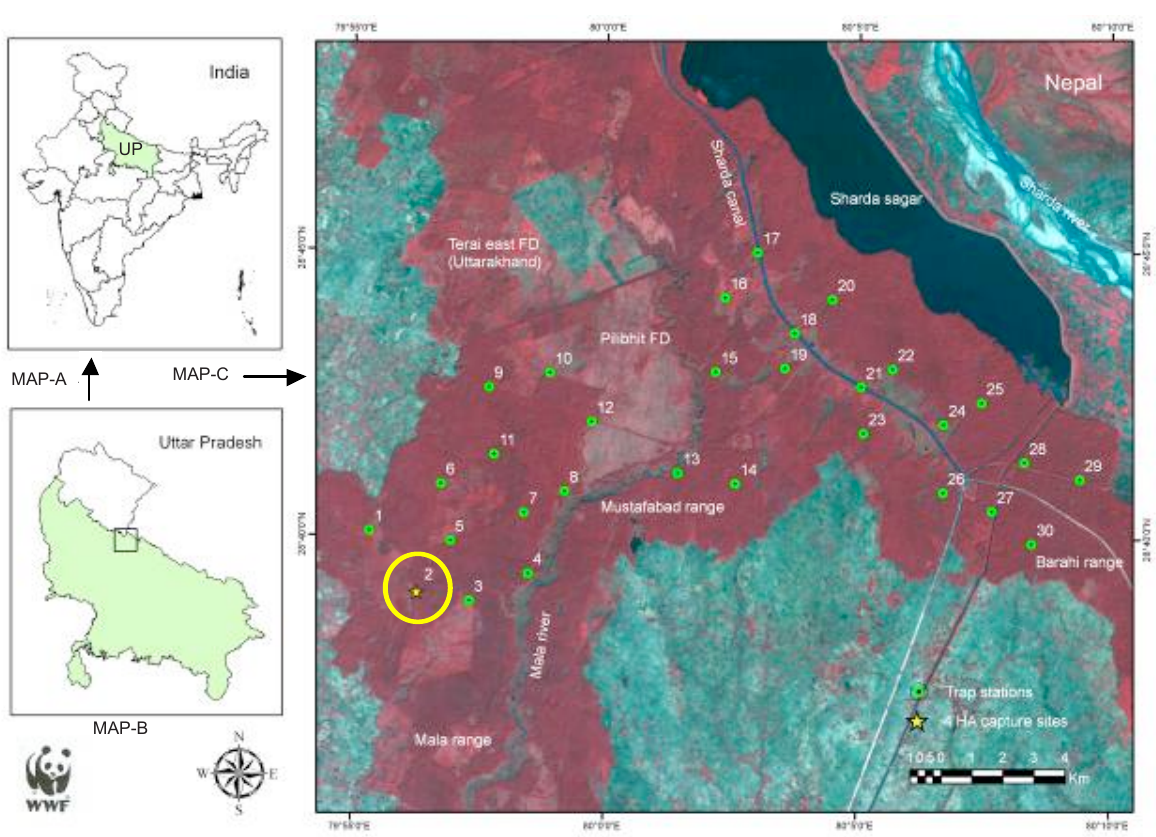
Figure 1. State of Uttar Pradesh (U.P. in Map-A) showing the location of Pilibhit Forest Division (square in Map-B). Map-C shows locations where camera traps were mounted (green dots) and the site where Four-horned Antelope was photographed (site no.2, marked with yellow circle) in Marwari beat of Mala range of Pilibhit Forest